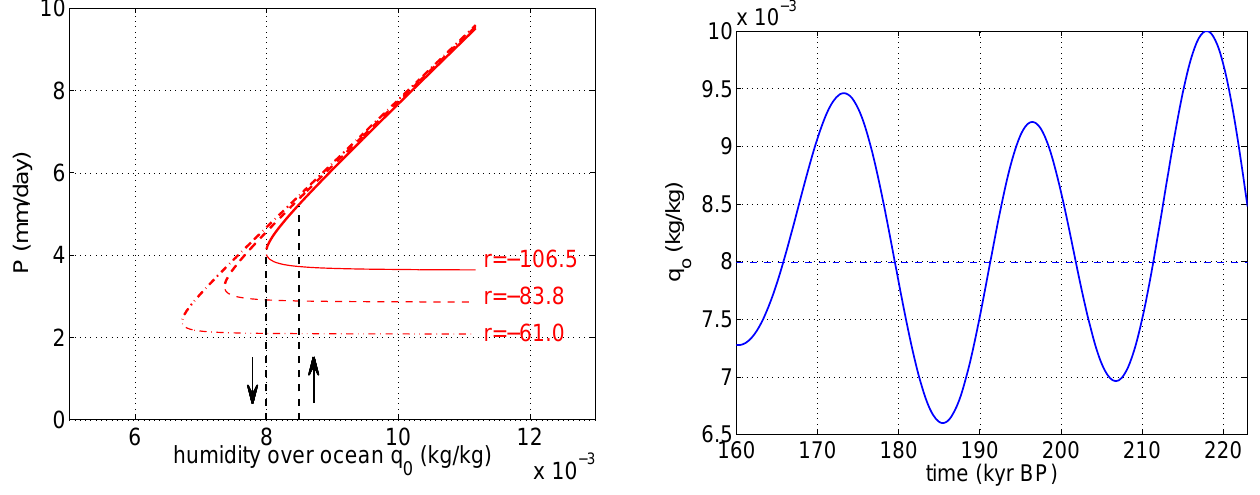
Fig. 12. Time series of q o used for the application of the conceptual model. q o is assumed to vary linearly with northern hemisphere (65 ◦ N) summer insolation. The horizontal dashed line marks q c o . NHSI would act to exacerbate the threshold effect,